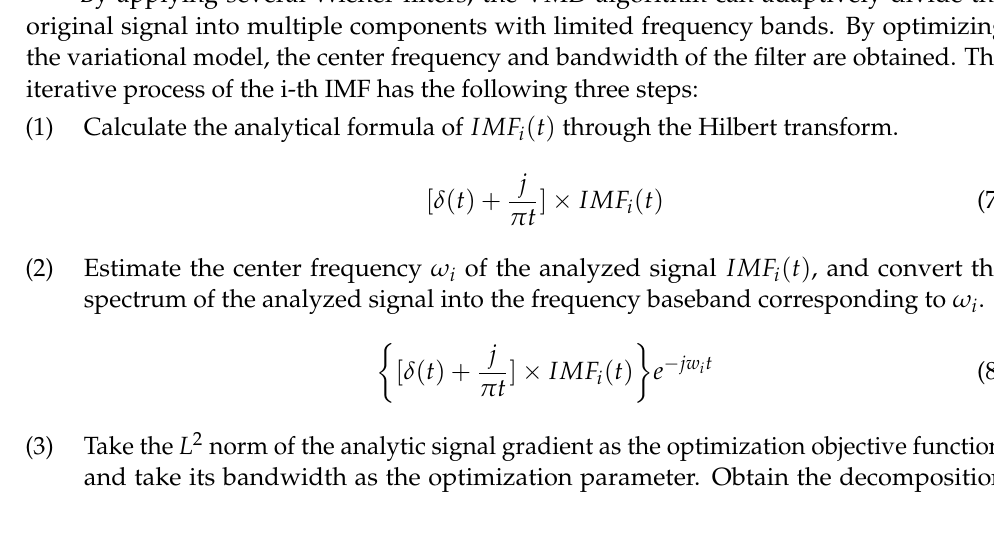
Figure 2. Filtering result of 1